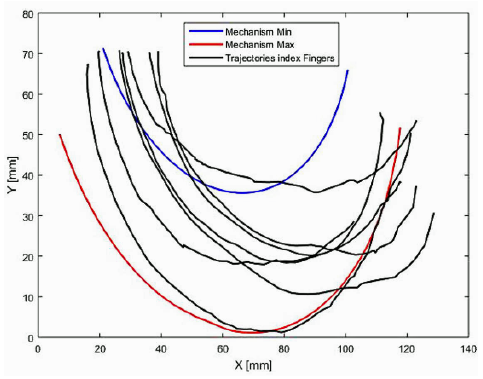
Figure 14. Workspace trajectories and index fingers within the A-AFiM.